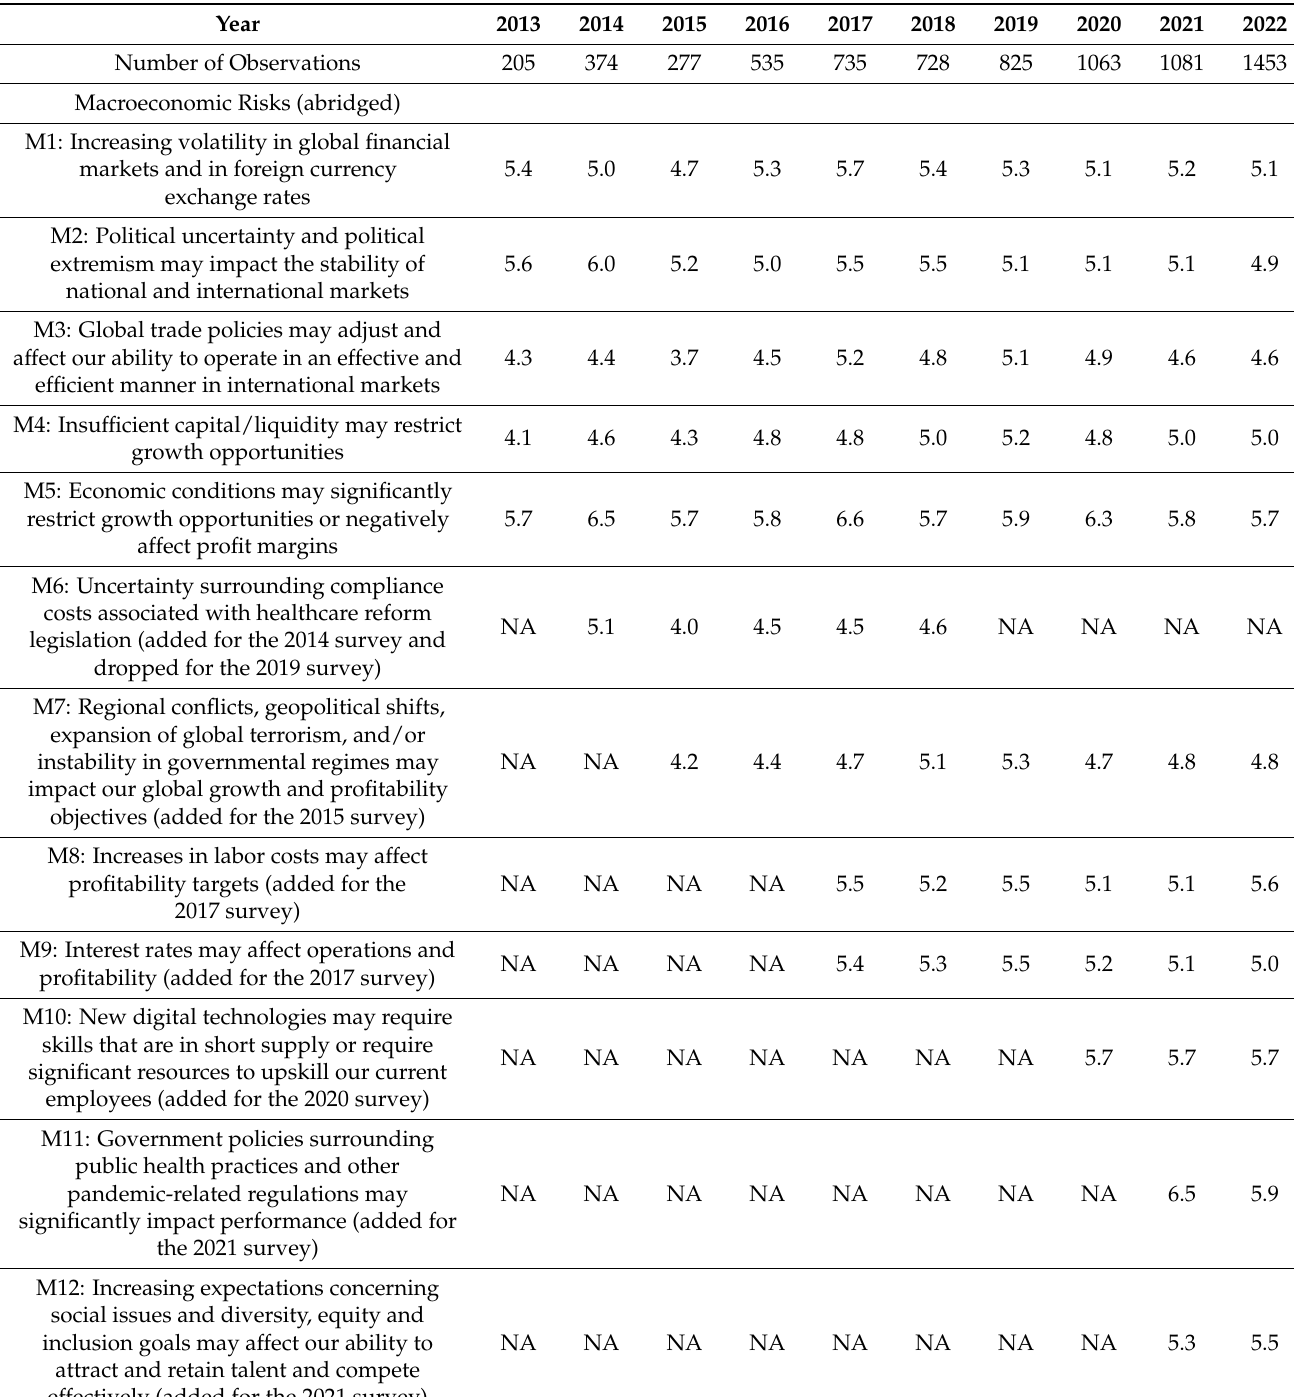
Table 6. Survey Responses for Macroeconomic Risk